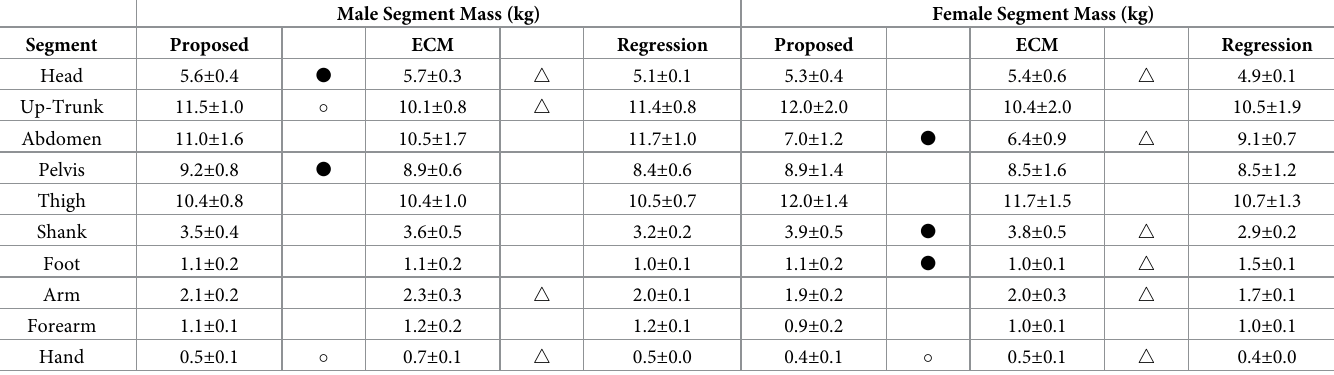
Table 3. Body segment mass estimates (mean ± SD in kg) obtained using the proposed method, the ECM approach, and regression modelling for both male and female